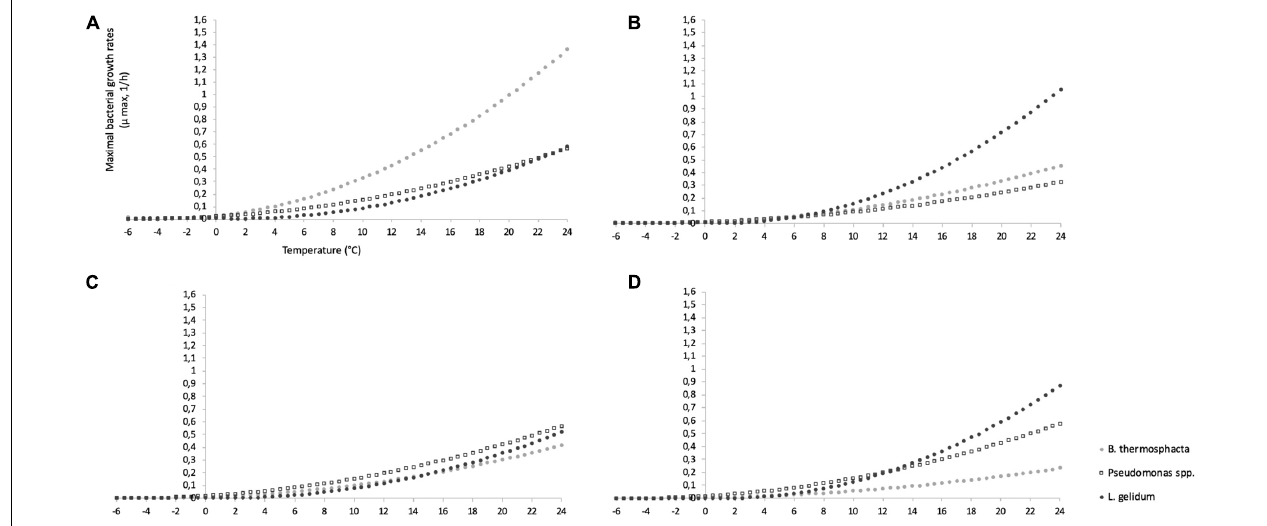
FIGURE 4 | Evolution of µ max between a large range of temperature (from − 6 to + 25 ◦ C) for mono-culture experiments in FW (A) and MAP (B) , and for co-culture experiments in FW (C) and MAP (D) .